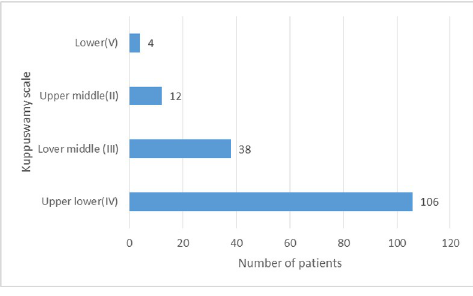
Fig 1. Socio-economic class based on Kuppuswamy